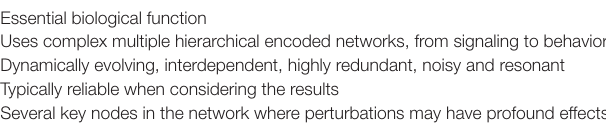
TablE 1 | Features of biological information processing. Essential biological function Uses complex multiple hierarchical encoded networks, from signaling to behavior Dynamically evolving, interdependent, highly redundant, noisy and resonant Typically reliable when considering the results Several key nodes in the network where perturbations may have profound effects